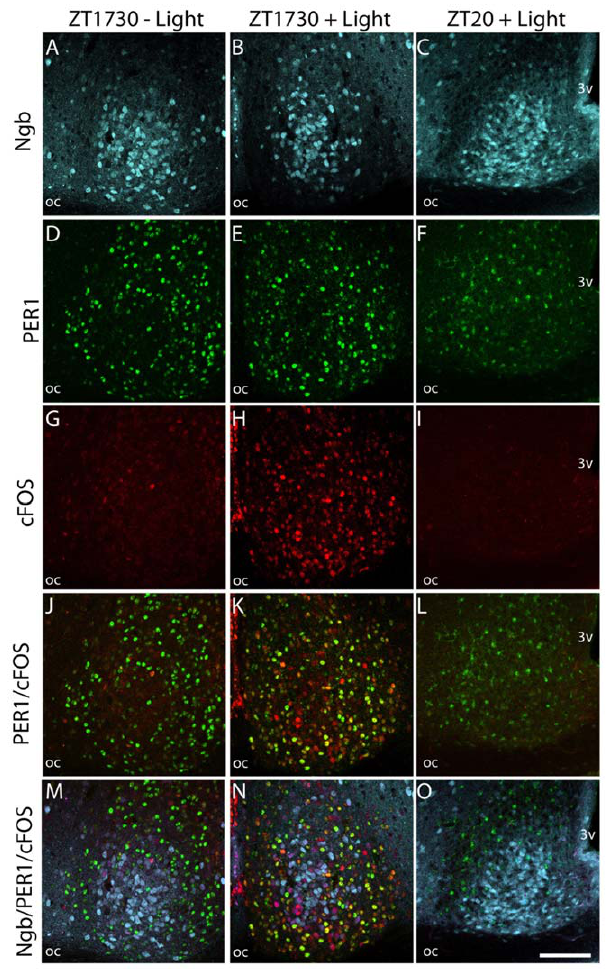
Figure 5. Light induced cFOS and PER1 in Ngb expressing neurons of the mouse SCN. The first column shows sections of mid SCN from a mouse euthanized at ZT 1730 without light stimulation. Ngb-IR (light blue) A , PER1 (green) D and cFOS (red) G are shown. Expression of Ngb-IR and PER1, but not cFOS-IR can been observed. Merged images J–M shows PER1/cFOS and PER1/cFOS/Ngb-IR, respectively. There was no co-expression between PER1 and Ngb. Similarly, in the mid column SCN from a mouse euthanized 90 min after light stimuli is shown. Note strong expression of cFOS ( H ) and a high degree of co-localization (yellow) with PER1-IR ( K ). No co-expression could be observed between Ngb and PER1-IR, but a subpopulation of Ngb-IR cells in the core was found to be cFOS positive ( N ). In the last column SCN from a mouse euthanized at ZT 20 after having received a 30 min light stimulus at ZT 16 is shown. Note cFOS-IR has disappeared ( I ) and substantially less PER1-IR ( L ) is expressed in both the nuclei and cytoplasm. No co-expression between Ngb-IR and PER1-IR could be seen ( O ). Oc; optic chiasm; 3 V, 3 rd ventricle. Scale bar 100 m m.